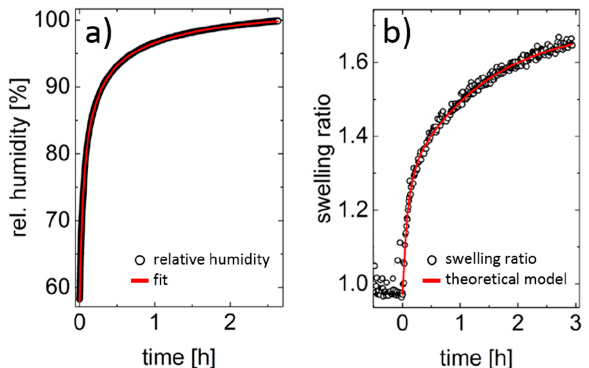
Figure 6. ( a ) Evolution of the relative humidity inside the vapor chamber. The curve is fitted with an exponential function; ( b ) Swelling ratio of the PSPP 80 film upon increasing relative humidity at 12 °C measured in-situ with SR. The data are fitted by a theoretical model, see text. Table 1. Values of the fitting parameters χ eff and τ swell for the thin films from PSPP 80 with H 2 O obtained by SR.